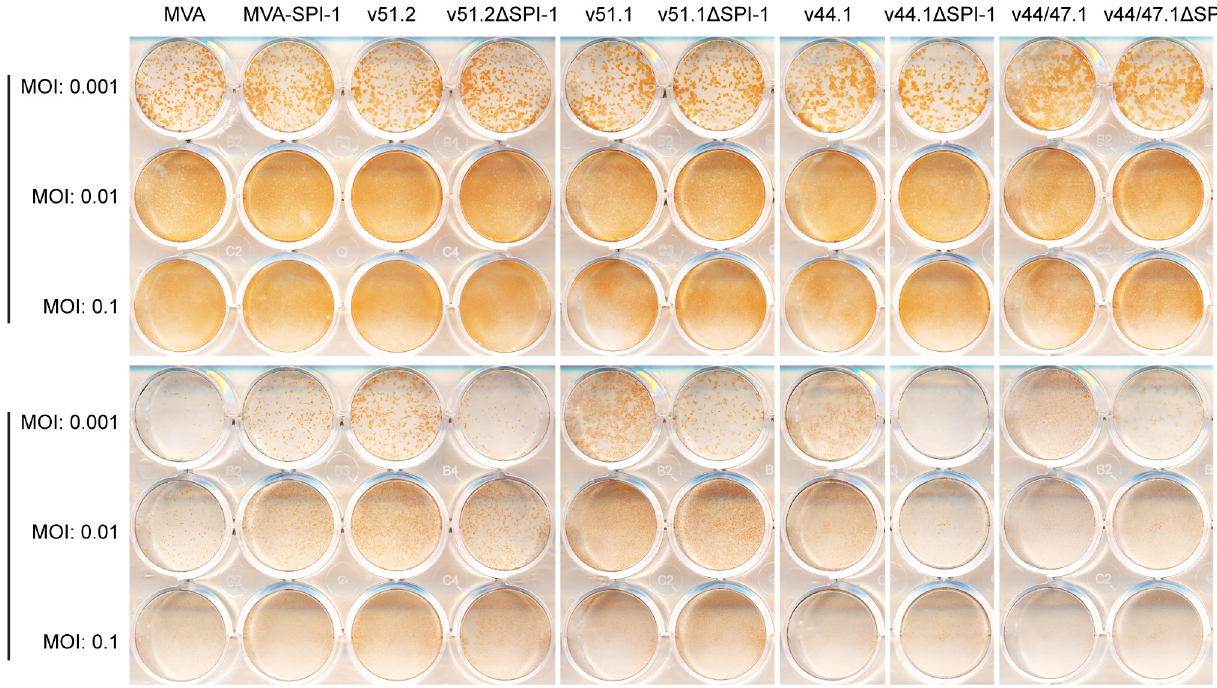
PLOS Pathogens| https://doi.org/10.1371/journal.ppat.1007710 May 30,